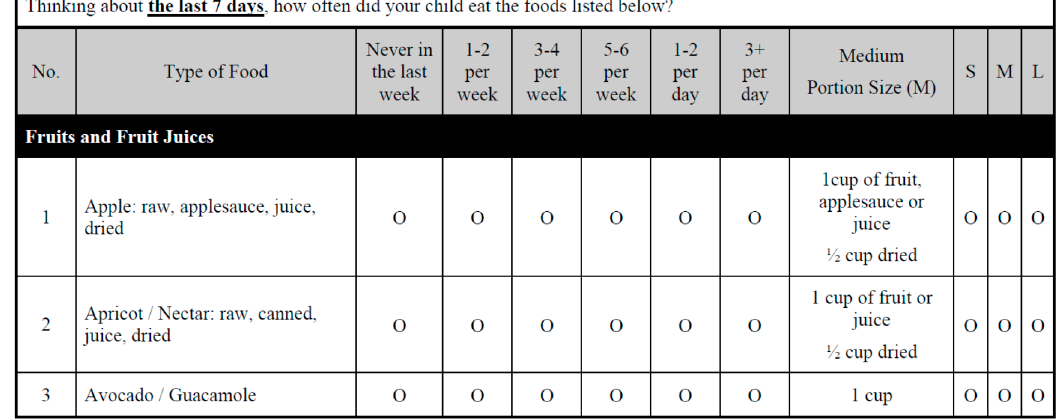
Figure 1. Example of the Manganese and Iron Food Frequency Questionnaire heading, first food group, and first three food item.